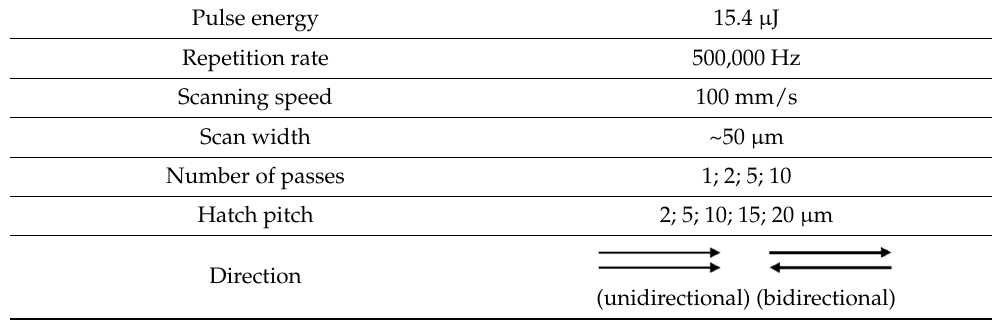
Table 3. An overview of the laser parameters.